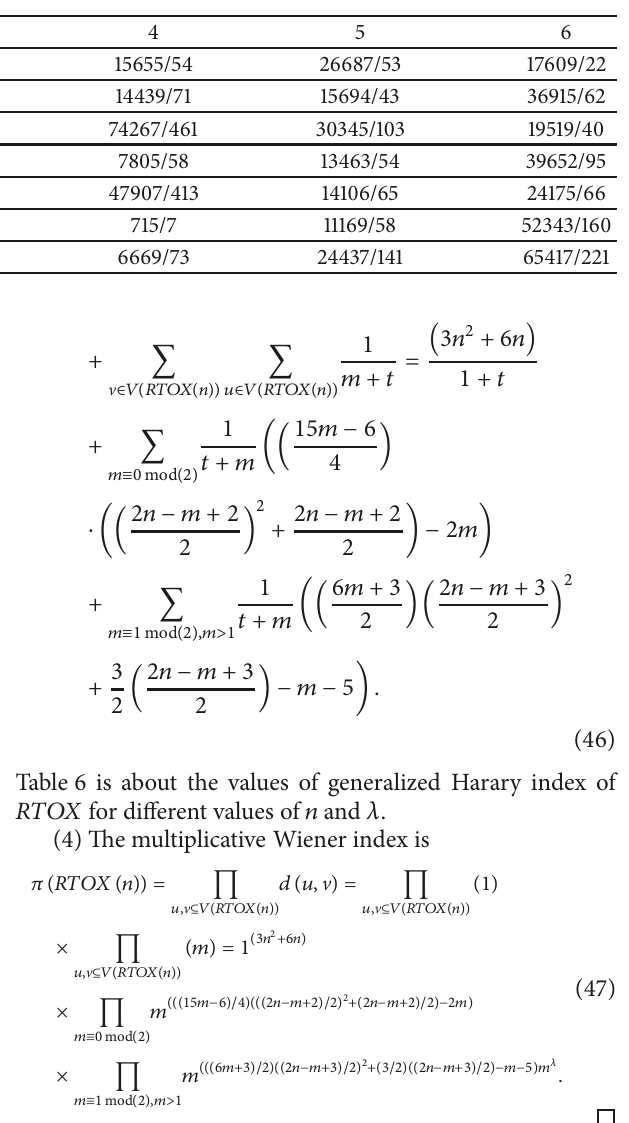
Table 6: Generalized Harary index of 𝑅𝑇𝑂𝑋